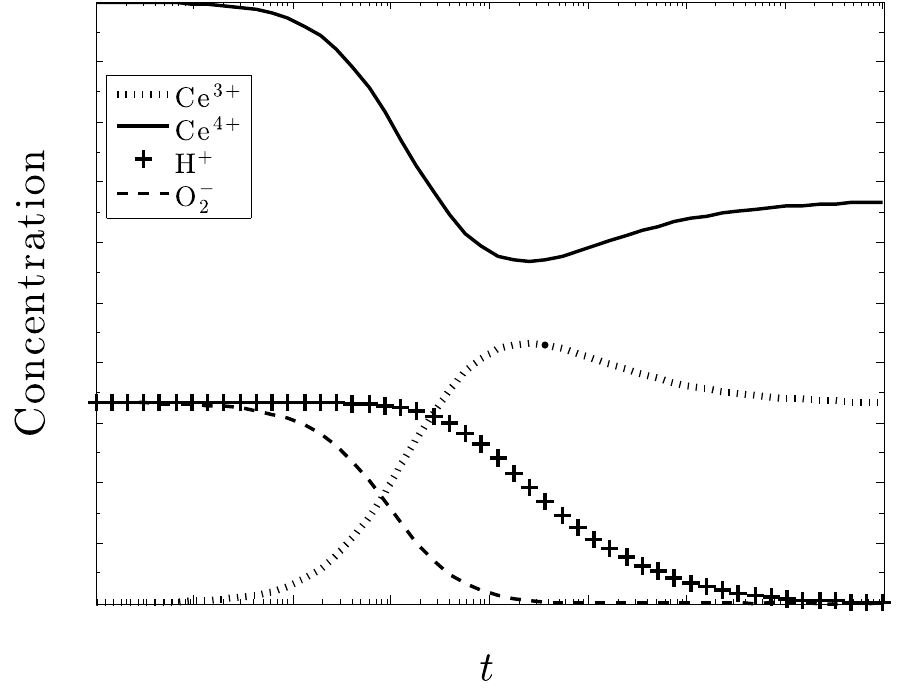
Figure 5. k 4 dominates and the recovery from low pH and excess hydrogen peroxide presumably eliminates the pathenogenisis. Note, that the superoxide is not completely eliminated.